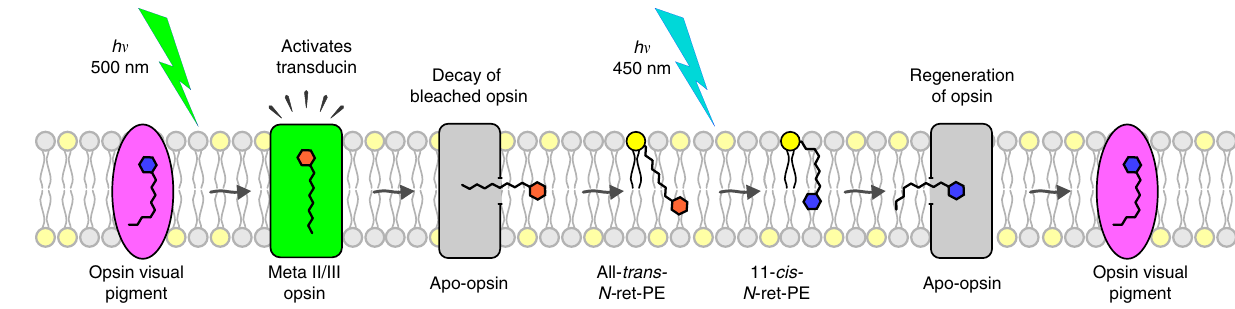
Fig. 6 Retinyl-lipid photoregeneration of opsins in rod or cone OS. The results presented here suggest the existence of a light-driven mechanism to regenerate visual pigments in rod and cone OS through photoisomerization of retinyl-lipids. This diagram shows the phospholipid bilayer of a rod OS disk. Rhodopsin absorbs a 500-nm photon ( hv ) that photoisomerizes its 11cRAL chromophore to atRAL, converting the pigment to its active metarhodopsin II/III (meta II/III) state. After a brief signaling period, the bleached opsin decays, releasing free atRAL into the bilayer. The atRAL reversibly condenses with PE (yellow circles) to form at- N- ret-PE. Protonated at- N- ret-PE is converted speci fi cally to 11c- N- ret-PE upon absorption of a 450-nm photon. Spontaneous hydrolysis of 11c- N- ret-PE yields free 11cRAL, which irreversibly combines with unliganded apo-opsin to form a new rhodopsin pigment. A similar process occurs in cone OS to regenerate cone